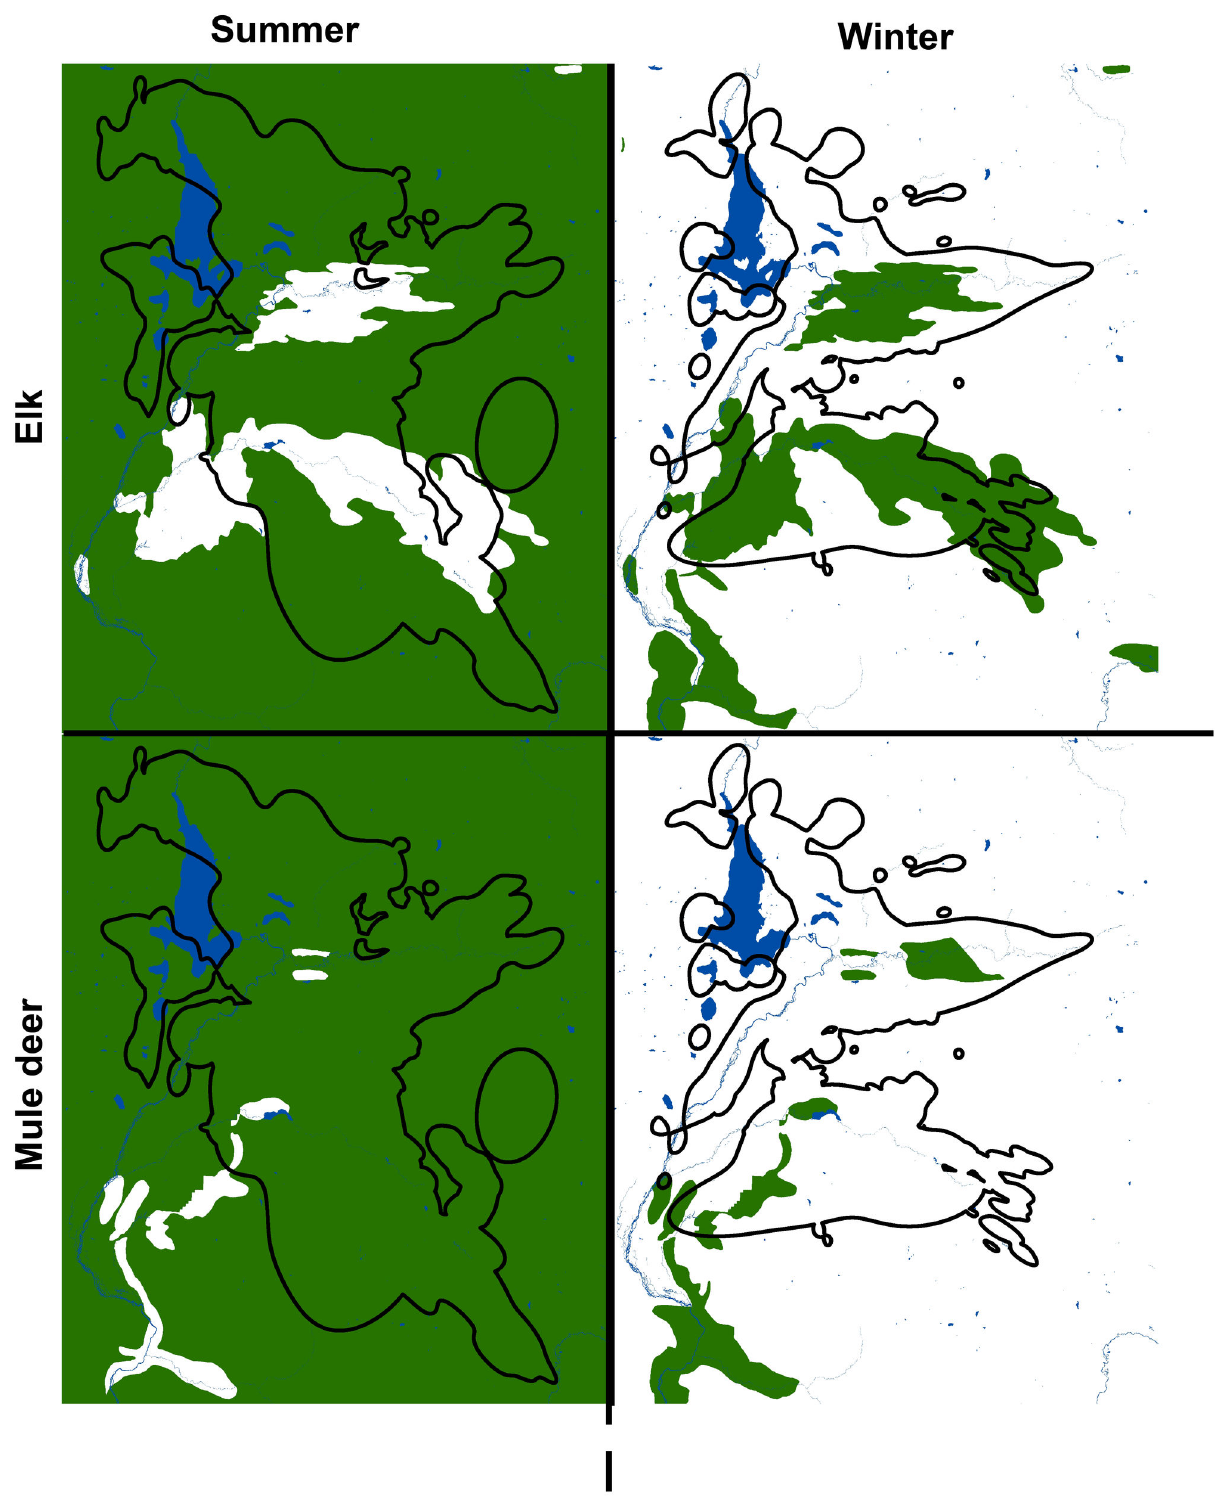
Figure 2. Seasonal ranges of mule deer, elk, and cougars in the study area. Seasonal ranges of mule deer and elk in green in the study area, as they overlap with the seasonal ranges of cougars outlined in black. The large lake is Jackson Lake in Grand Teton National Park. doi: 10.1371/journal.pone.0083375.g002 PLOS ONE |